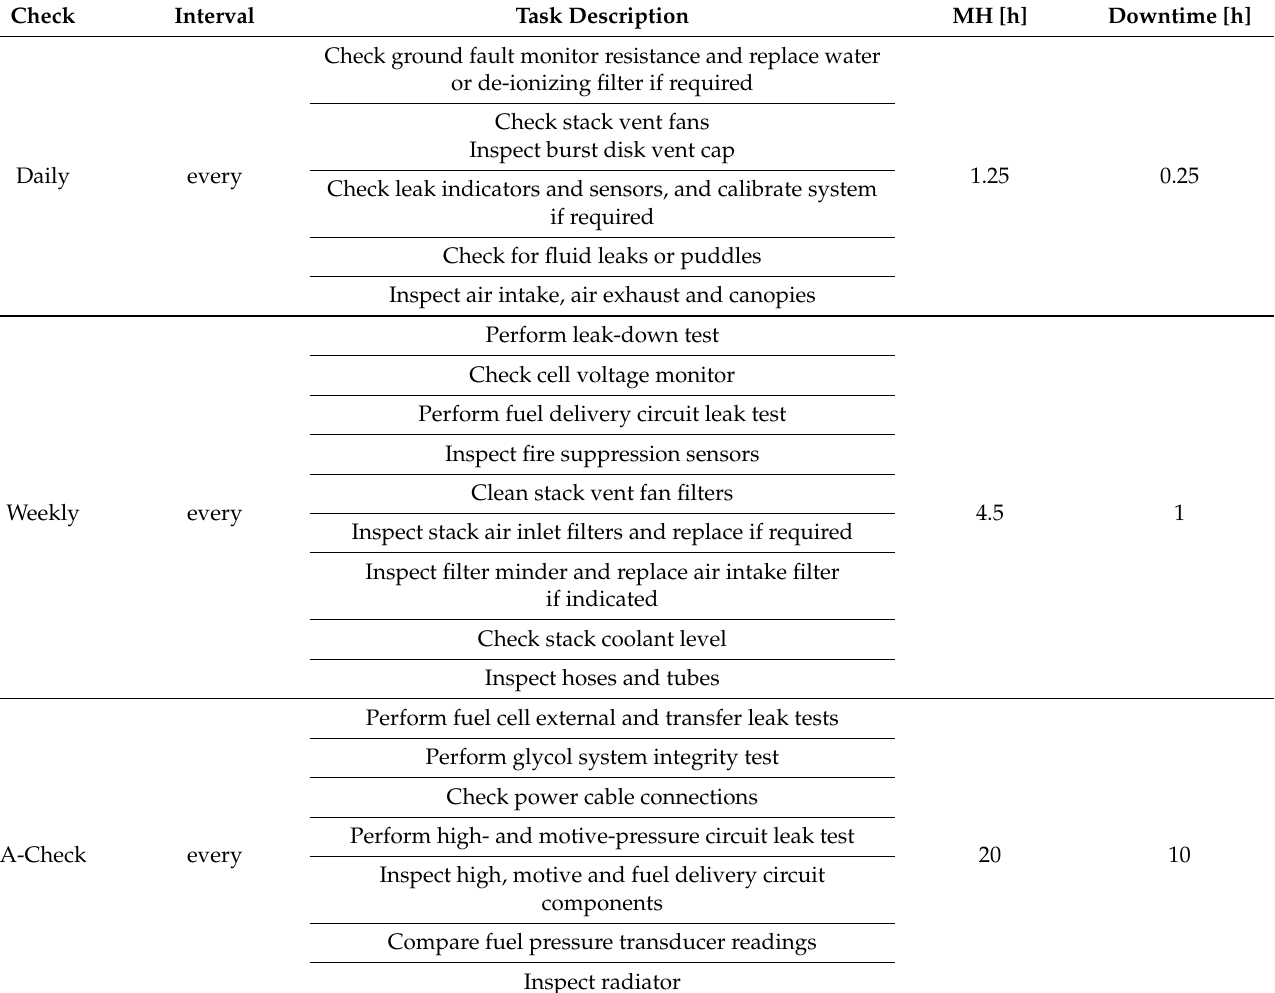
Table A1. Overview of all necessary maintenance tasks for an aircraft using PEMFC in combination with LH2 as an APU (without consideration of tank maintenance). Reproduced with permission from DLR e.V.